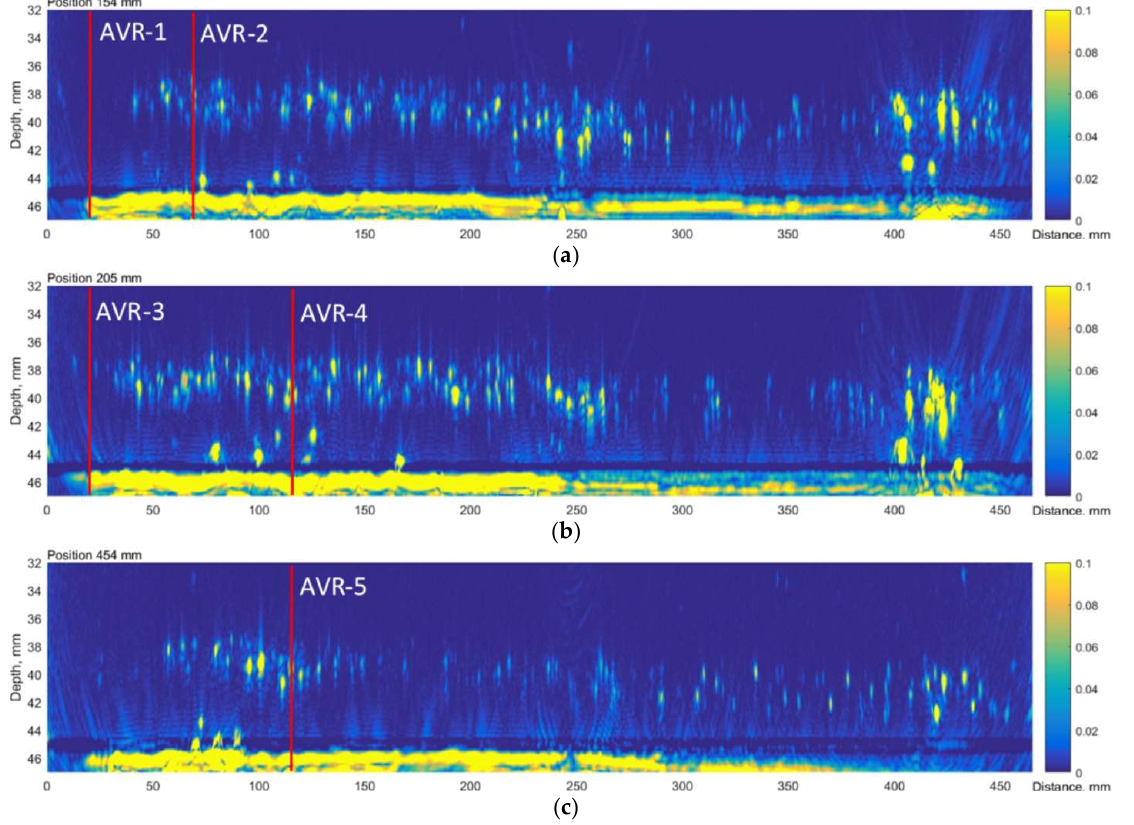
Figure 7. TFM reconstructions at different circumferential locations, indicating positions of AVR measurements: ( a ) 1st and 2nd measurement points, ( b ) 3rd and 4th measurement points, ( c ) 5th measurement point. Vertical colour bar represents the peak-to-peak amplitude in arbitrary units.